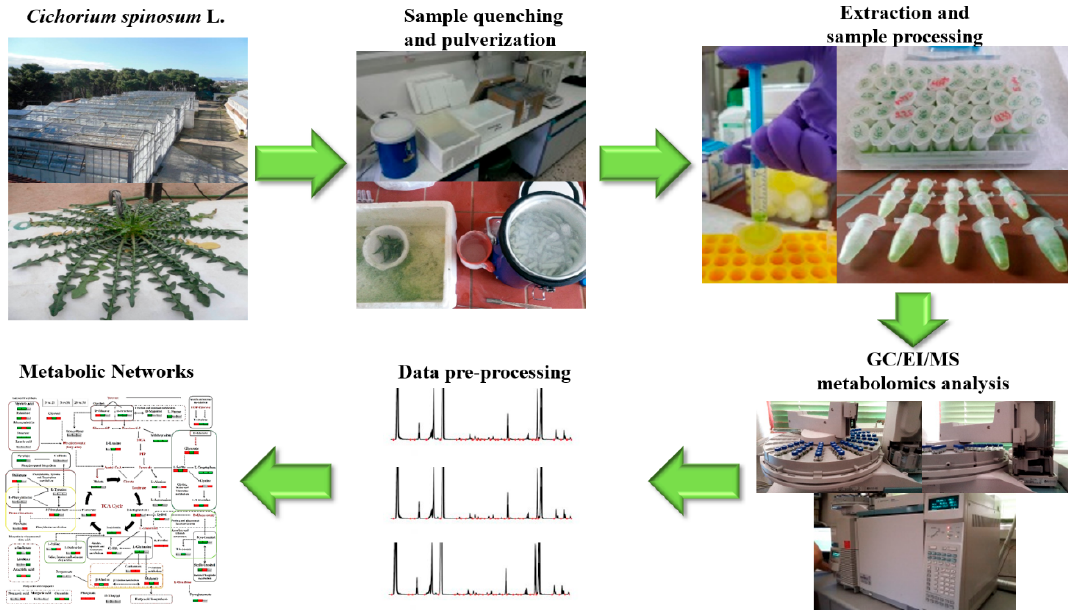
Figure 1. Pipeline for the dissection of the effects of two different N supply levels—low at 4 mmol L − 1 and high at 16 mmol L − 1 —combined with three different NH 4 /total-N fractions (5%, 25%, and 50%, respectively) on the metabolism of Cichorium spinosum L. plants, employing gas